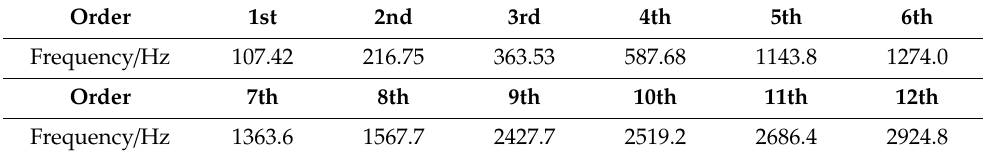
Table 6. Nature frequencies of the first 12 orders of nature frequencies of the optimized upper arm.